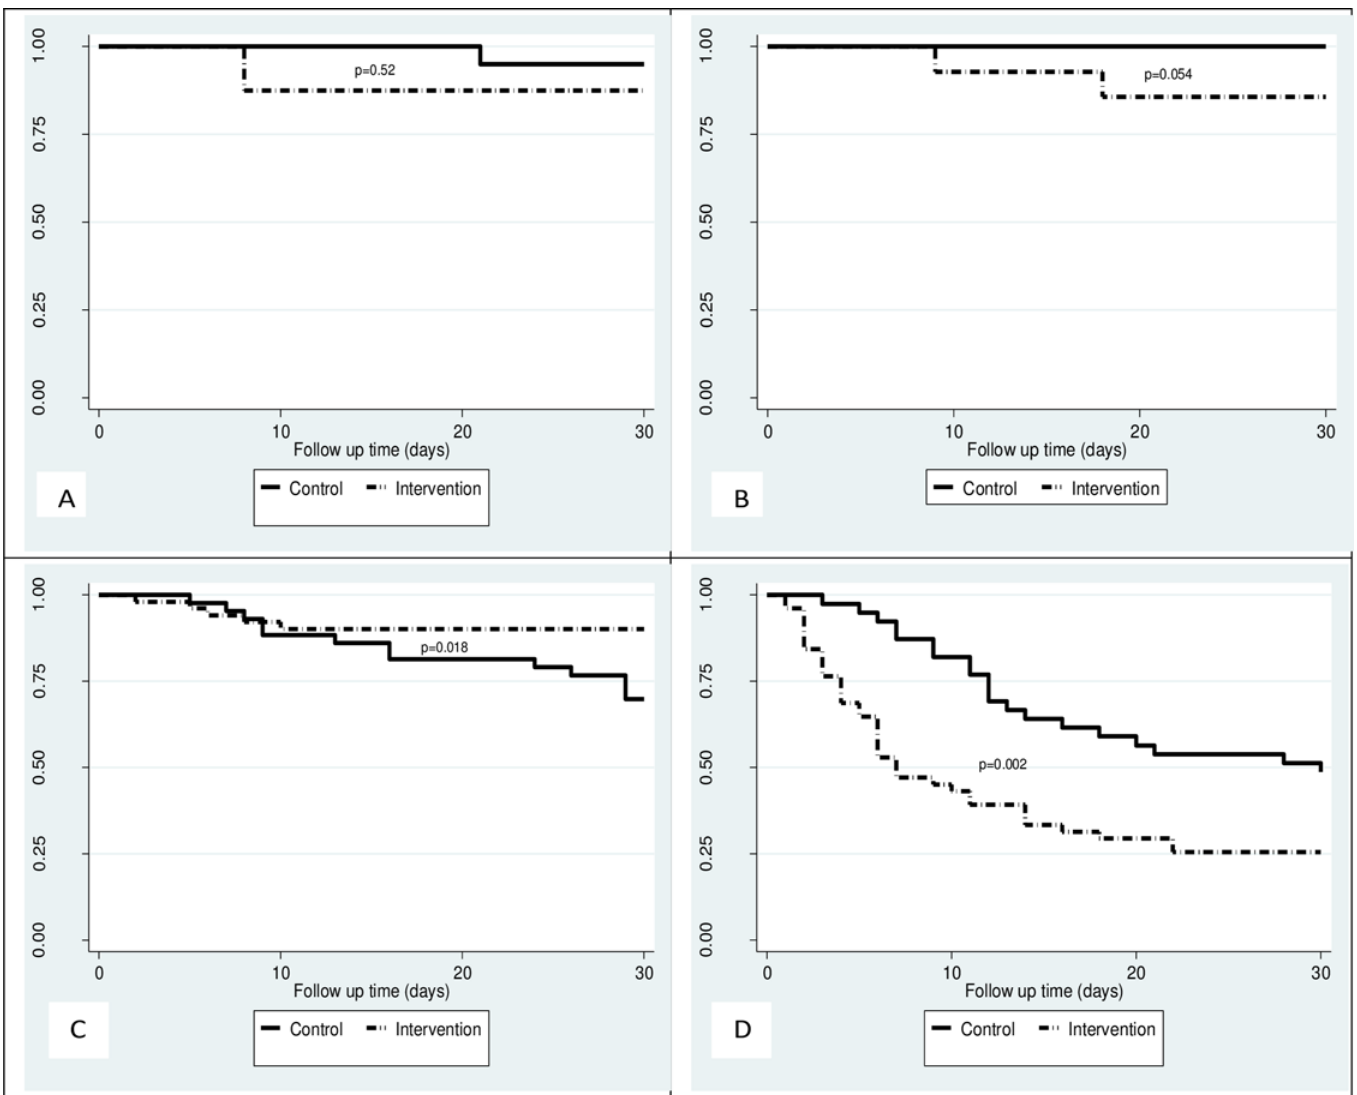
Fig 3. Kaplan Meier survival curves by stroke severity category comparing survival of patients in the control group and the intervention group. (A) shows Kaplan Meier curves comparing survival of participants with mild stroke in the control and intervention groups. (B) shows Kaplan Meier curves comparing survival of participants with moderate stroke in the control and intervention groups. (C) shows Kaplan Meier curves comparing survival of participants with severe stroke in the control and intervention groups. (D) shows Kaplan Meier curves comparing survival of participants with very severe stroke in the control and intervention groups. The p values were obtained from the log rank